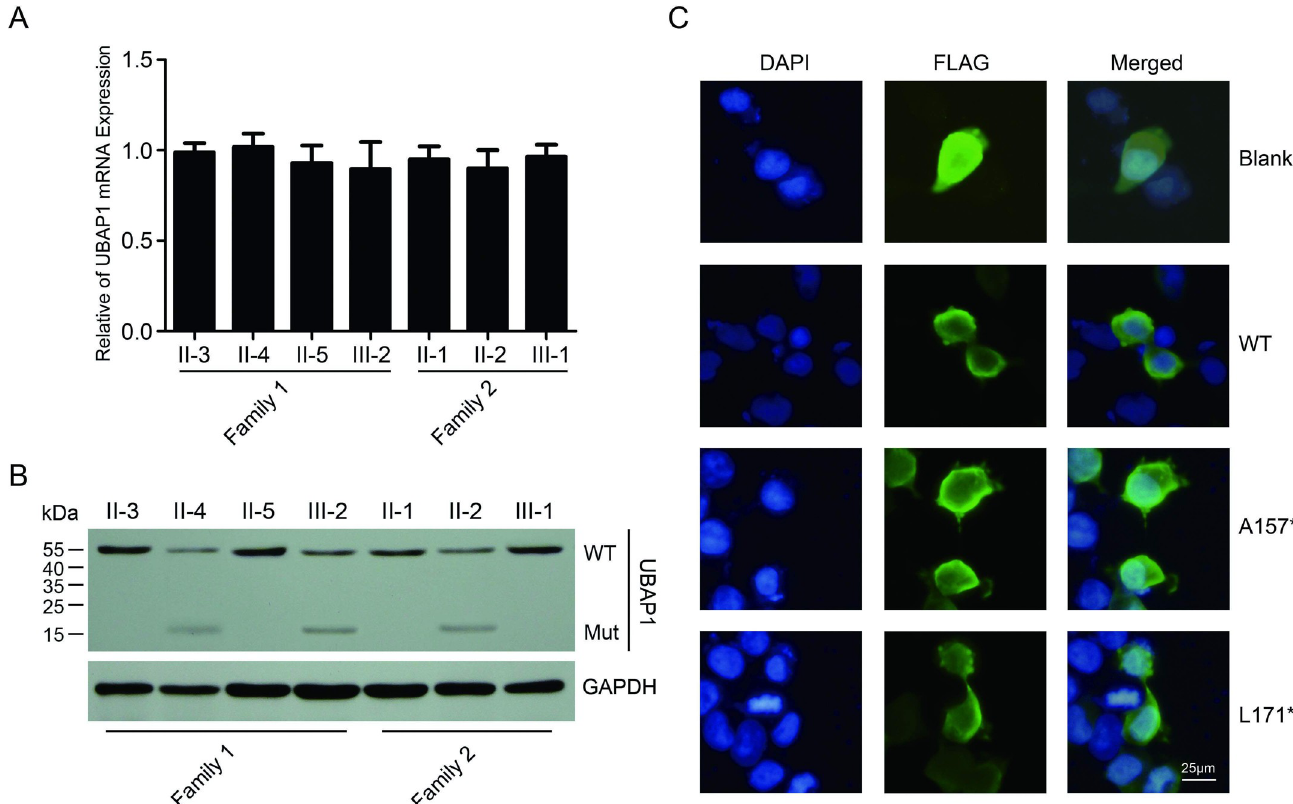
Fig 3. Characterization of A157 � and L171 � mutants. (A) mRNA expression levels of UBAP1 in lymphocytes were analyzed by qPCR assays. Data were normalized to the levels of GAPDH within each sample (n = 3). The data are presented as the mean ± SE. (B) Protein levels of UBAP1 in lymphocytes were examined by Western blotting. GAPDH was used as an internal control. (C) Localizations of FLAG-tagged A157 � and L171 � analyzed in neuro-2a cells via immunofluorescent assays showing they did not disrupt the subcellular localization of UBAP1.